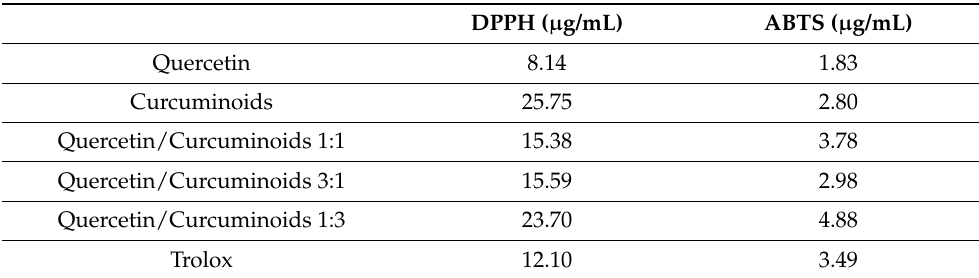
Figure 1. ( A ) DPPH radical scavenging activity of quercetin, curcuminoids and quercetin/curcuminoid mixtures. ( B ) Trolox equivalent antioxidant capacity (TEAC) of quercetin, curcuminoids and quercetin/curcuminoid mixtures. Table 2. The IC 50 values of quercetin, curcuminoids and 1:1, 3:1 and 1:3 quercetin/curcuminoid mixtures obtained from DPPH and ABTS